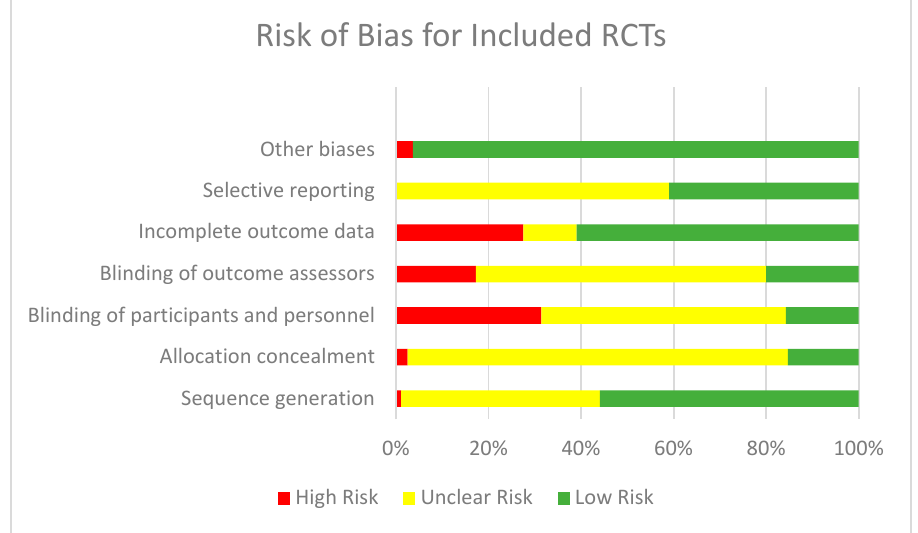
Figure 2. Summary risk of bias for included randomized controlled trials (RCTs).